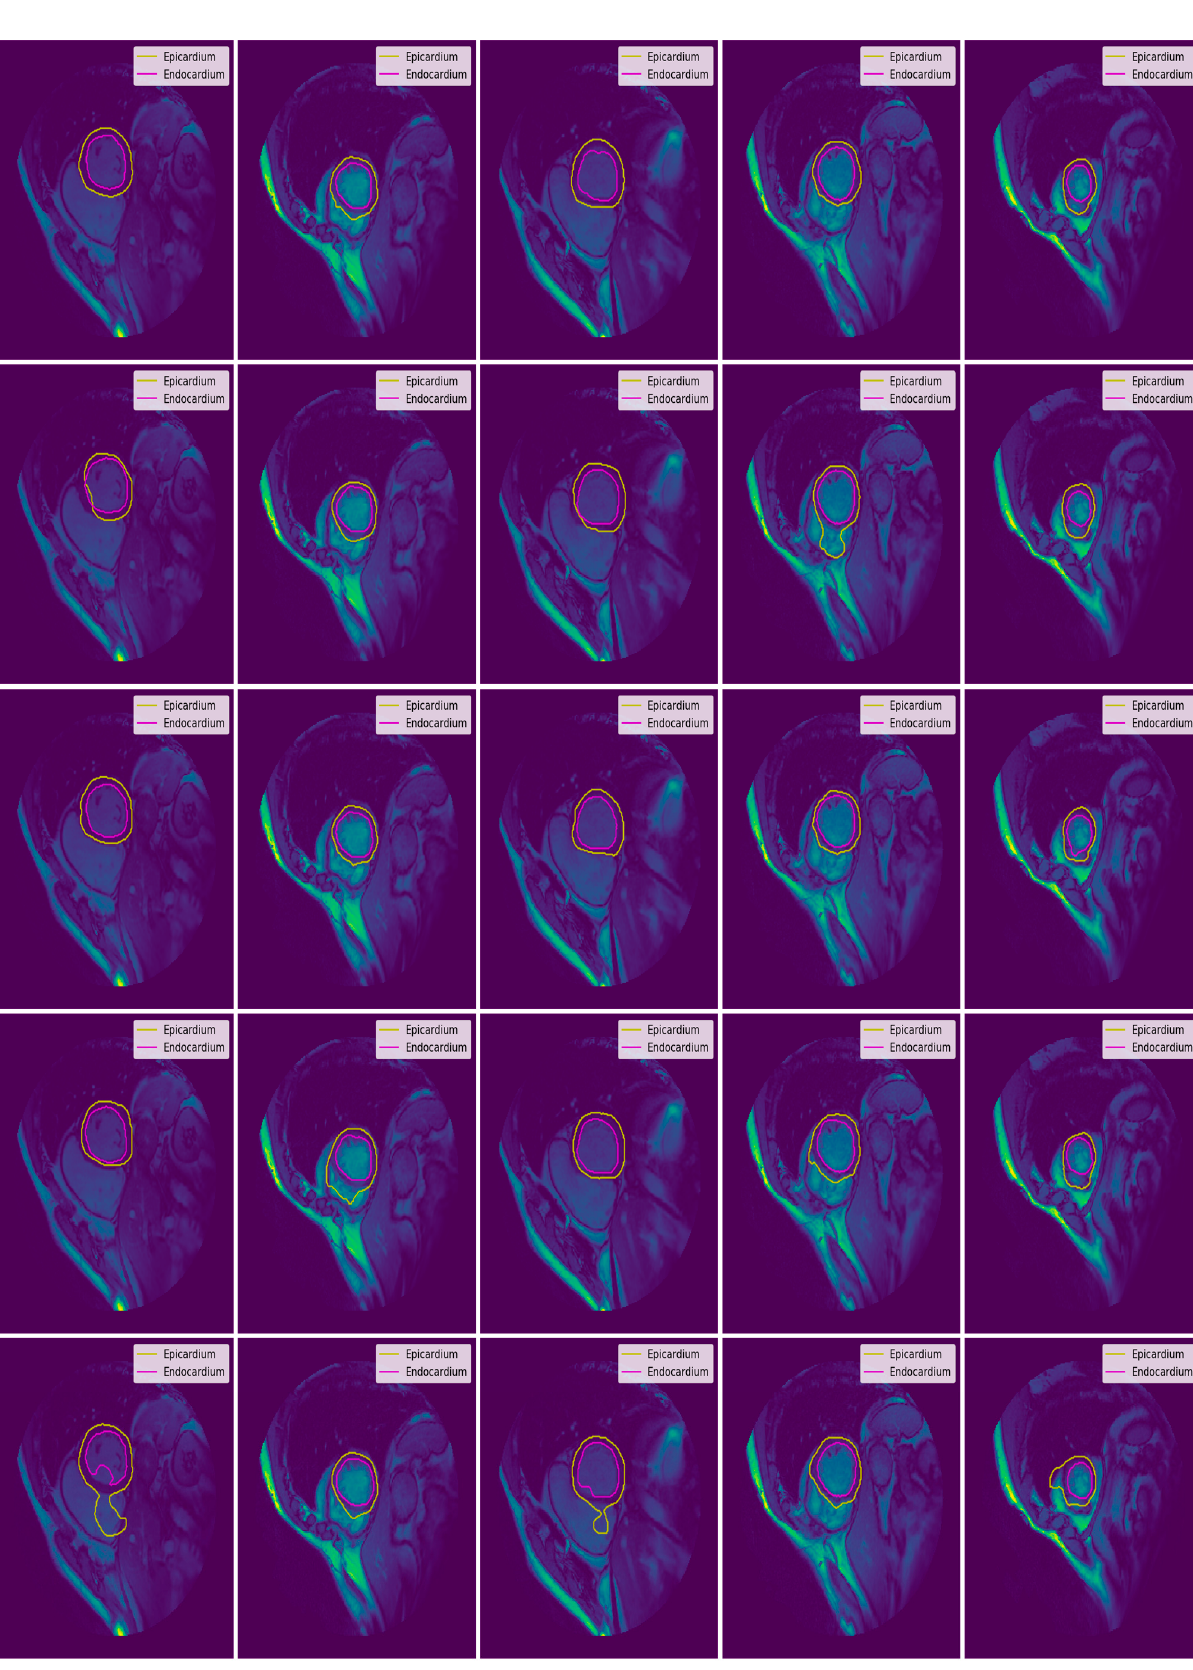
Figure 21. Automatic segmentation results of epicardium and endocardium boundaries from the testing set of a normal patient (SC-N).